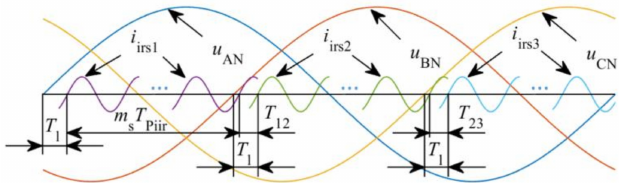
Figure 9. Phase relationship between the single-phase irregular